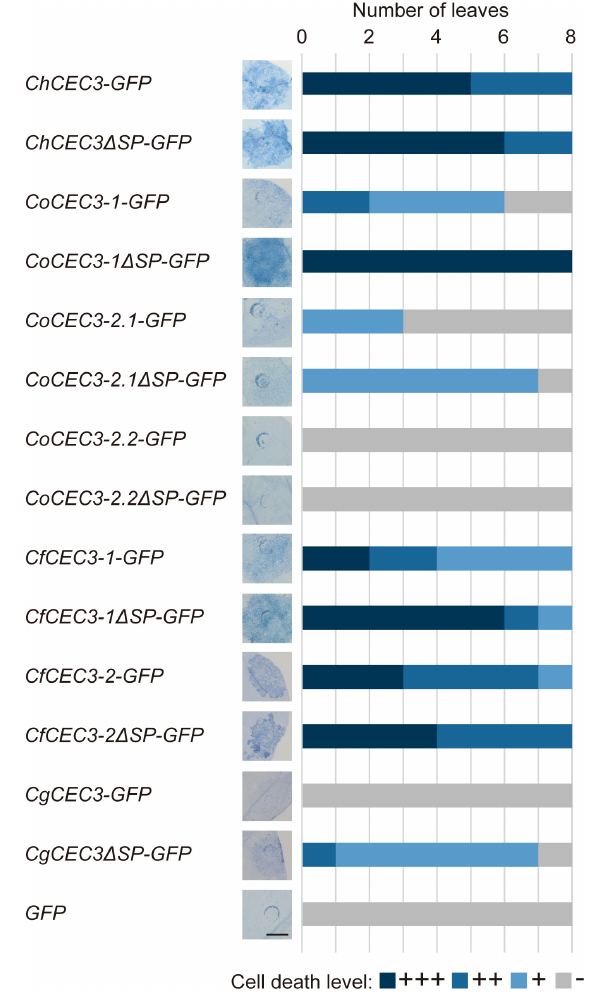
ChCEC3-GFP in N. benthamiana leaf epidermal cells.